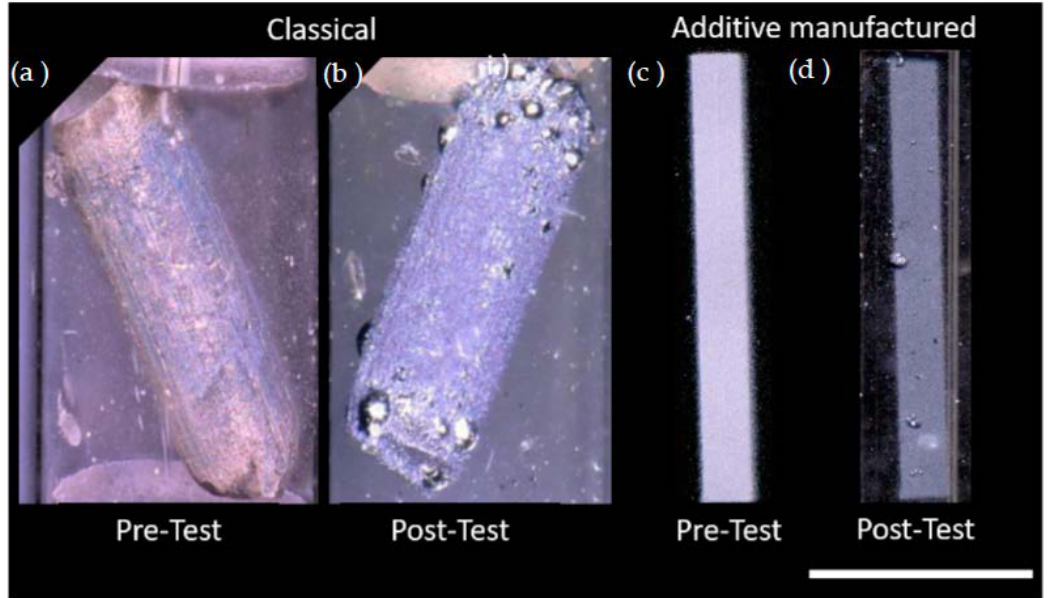
Figure 11. Comparison of melt behavior of classical and AM aluminum melt wires. Micrographs of the expected melt behavior of stock aluminum wire at room temperature ( a ) before DSC testing and ( b ) after DSC testing, for which the melting point was determined to be 660.5°C. Micrographs of the observed melt behavior of AM melt wires ( c ) before and ( d ) after furnace testing. Scale bar represents 1 mm. Through the progression of micrographs in Figures 5 and 6, material deposition is observed on the quartz tube, and this is more clearly visualized with the melt of zinc in Figure 5a, and material vaporization is further supported through Figure 6b. The zinc wire appears to fade while material buildup on the quartz tube demonstrates a direct relation- ship with test temperature. Through these observations, it is concluded that, during the testing process, a vapor alloying-like process has occurred, which is responsible for the melting point depression of the standard and AM aluminum melt wires. The ability to further miniaturize the melt wire package was introduced with the use of AM methods as it provides a way to deposit melt wire materials directly onto a sub- strate, and this allowed for an exploration into different encapsulation designs that would not otherwise be possible. The use of different melt wire materials for peak temperature monitoring also introduces the consideration that different materials have different melt- ing characteristics, and it is important to identify features before using them within an irradiation experiment. These changes can include but are not limited to rounded edges where sharp features had previously existed, the formation of a sphere of the entire melted line, or the development of bubbles or beads while the bulk of the material appears unaf- fected. Characterization of AM melt wires requires an assessment of each material’s melt behavior by identifying changes between XCT images before and after exposure to melt- ing temperatures. For this work, the evaluation method used for classical melt wires could not be used due to the opaque encapsulation material. Therefore, XCT was chosen because it is a capability that is available for PIE and it enables imaging of the melt wire materials through opaque encapsulation. With the use of the new encapsulation design, it was observed that melt identification could be made for tin and zinc after having exposed the melt wire capsule (with inert environment), but not for aluminum due to the low contrast between the aluminum melt wire and the SS316 substrate. Furthermore, the melt behavior of the same materials on a